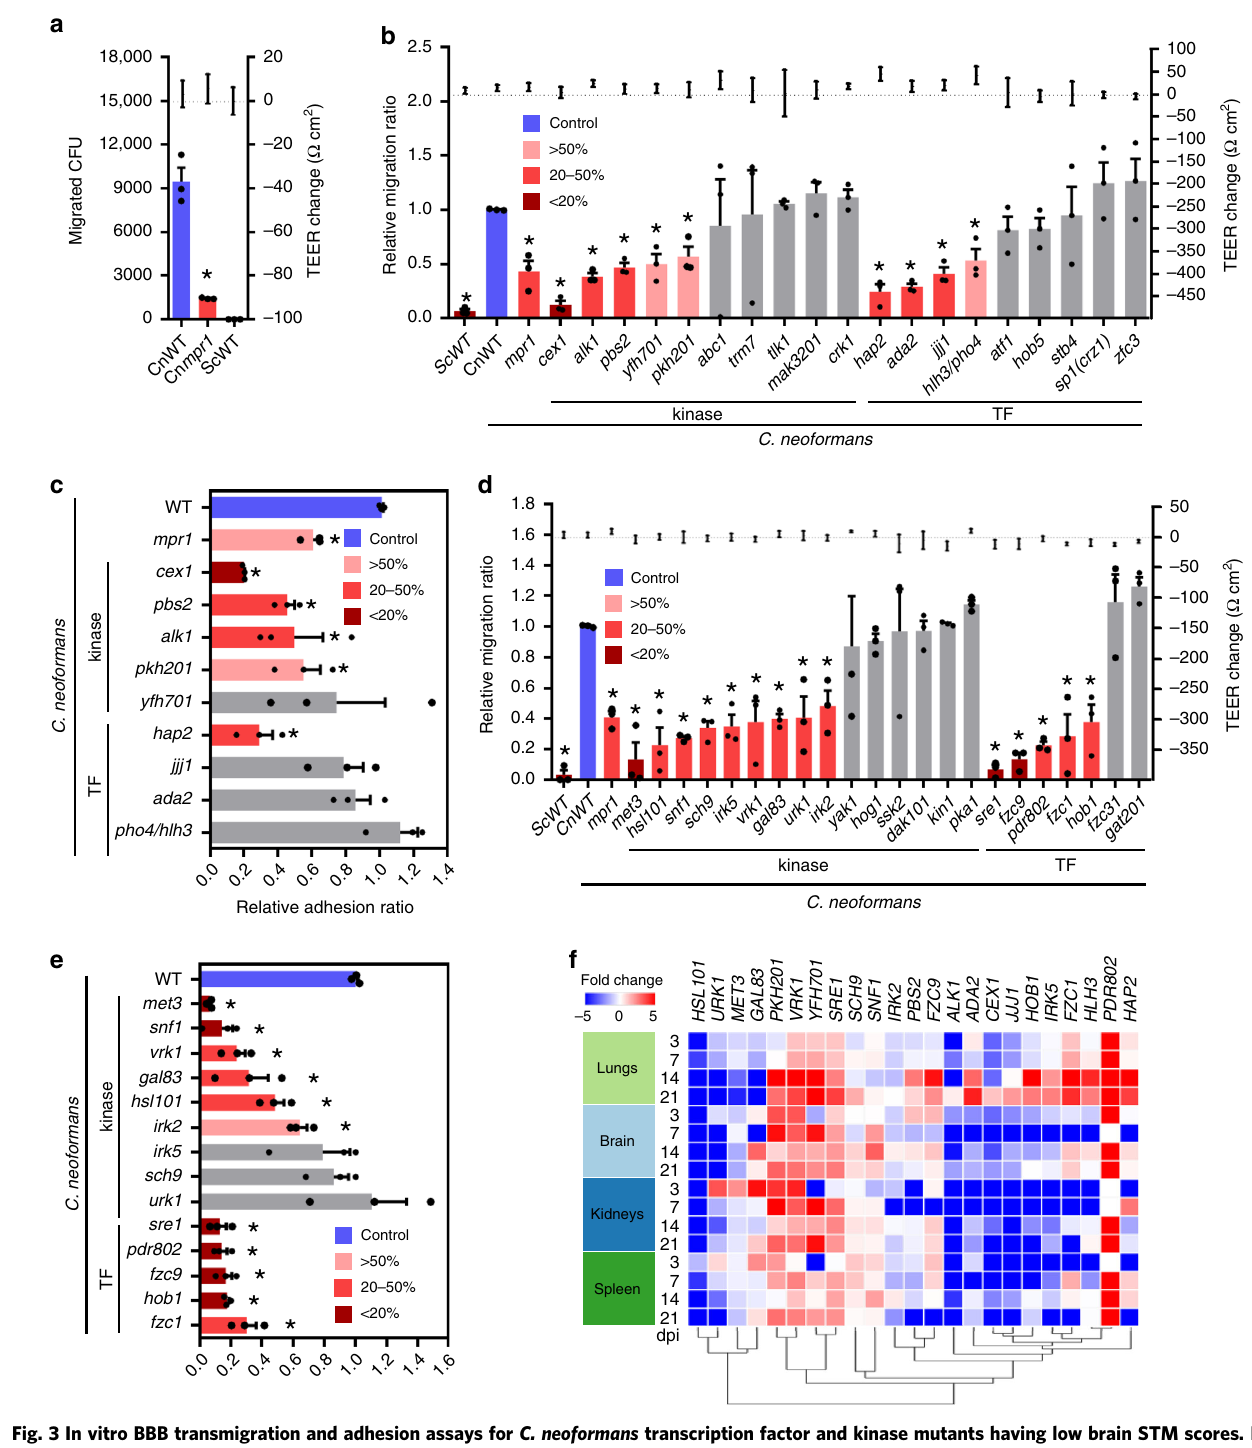
Fig. 3 In vitro BBB transmigration and adhesion assays for C. neoformans transcription factor and kinase mutants having low brain STM scores. BBB transmigration assays with hCMEC/D3-coated Transwell systems ( a , b , d ) and hCMEC/D3 cell adhesion assays ( c , e ). a , b , d Plates with inoculum of 10 5 yeast cells were incubated at 37 °C in CO 2 incubator for 24 h, and the number of yeast cells passing through the hCMEC/D3-coated Transwell was measured by CFU. S. cerevisiae WT ( Sc WT, S288C) and C. neoformans mpr1 Δ mutant ( Cnmpr1 ) were used as negative controls. a Left and right Y axes indicate the migrated CFU and the trans-endothelial electrical resistance (TEER) value, respectively. b , c The results of BBB transmigration ( b ) and adhesion assays ( c ) of brain-infection-related kinases and TFs discovered by brain-STM analysis. Left and right Y axes indicate the relative migration ratio and the TEER value, respectively. d , e The results of BBB transmigration ( d ) and cell adhesion assay ( e ) of core-virulence kinases and TFs discovered by dual STM analyses. Each mutant was analysed by more than three biologically independent experiments with three technical replicates. List of strains used in this Figure is described in Supplementary Data 4. a – e Data are presented as mean values ± standard error of the mean (SEM). Statistical signi fi cance of difference between Cn WT (H99 strain) and each mutant (*, P < 0.05) was calculated by two-tailed Student ’ s t test (unpaired, n = 3). f NanoString heatmap of BBB-crossing-related kinases and TFs was clustered by using